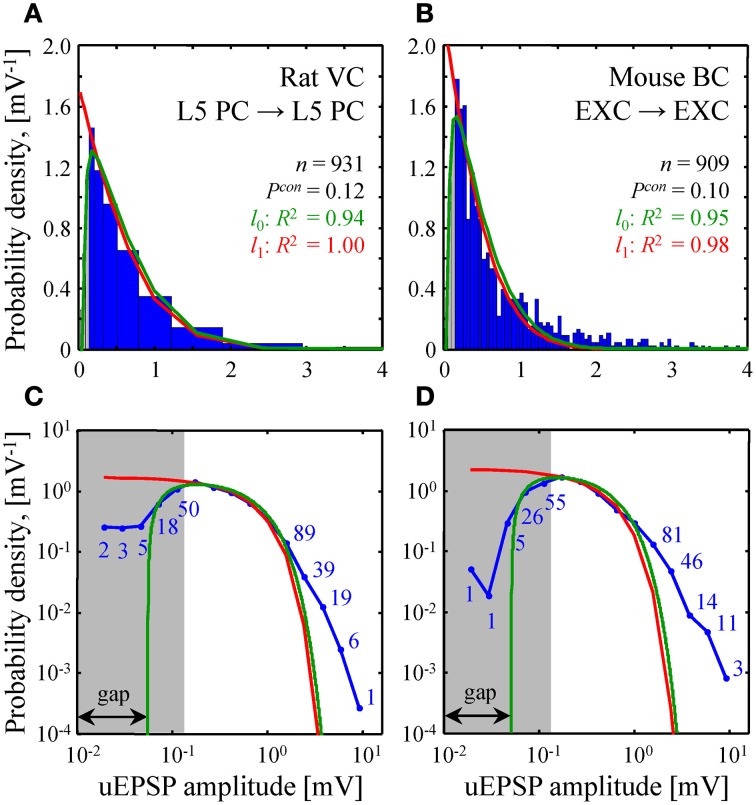
Comparison of theoretical and experimental distributions of connection weights. (A,B) Blue bars show distributions of uEPSP amplitudes in layer 5 of rat visual cortex (Song et al., 2005) and all layers of mouse barrel cortex (Lefort et al., 2009). These distributions were fitted with both the l0 (green) and l1 (red) constrained models (see Text S1 for details). Goodness of the fits is captured by the adjusted R2 coefficients, which are close to 1. (C,D) To examine how the two models fit the heads and the tails of the distributions of uEPSP amplitudes (blue line), (A,B) are re-plotted on a log-log scale. Blue numbers indicate the counts in the logarithmic bins. Data points, which fall below the uEPSP detection threshold and are thus unreliable, are highlighted in gray. The probability density in the l0 model has a gap between zero and non-zero connection weights; there is no such gap in the l1 model.